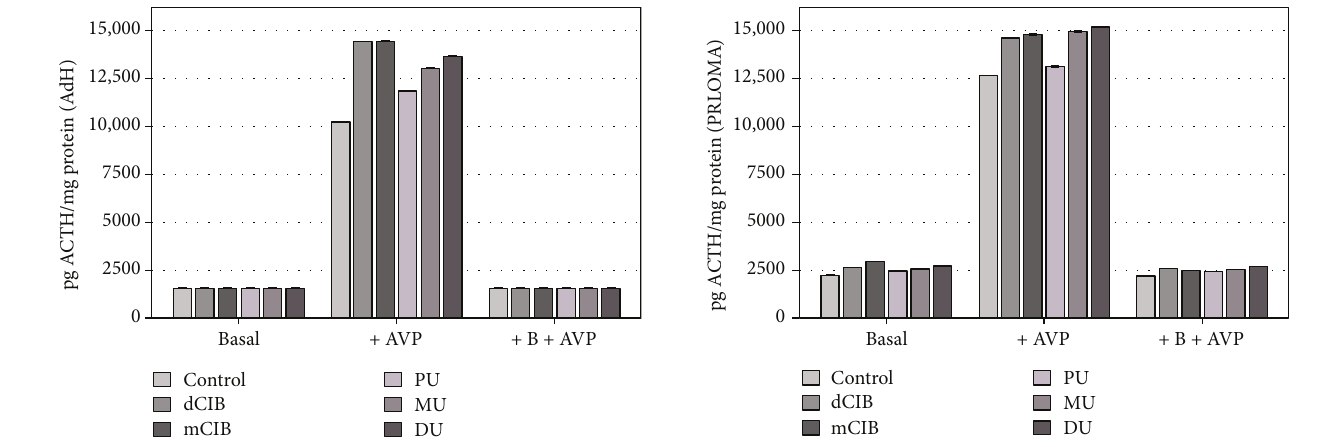
Figure 4: EDC e ff ects in the regulation of ACTH release in rat PRLOMA cultures, in vitro . Mean (ACTH level) ± SEM. The mean and SEM are calculated from n = 12 . Abbreviations: B=corticosterone: 1 μ g/ml; AVP=8-arginine vasopressin: 10 − 6 M,